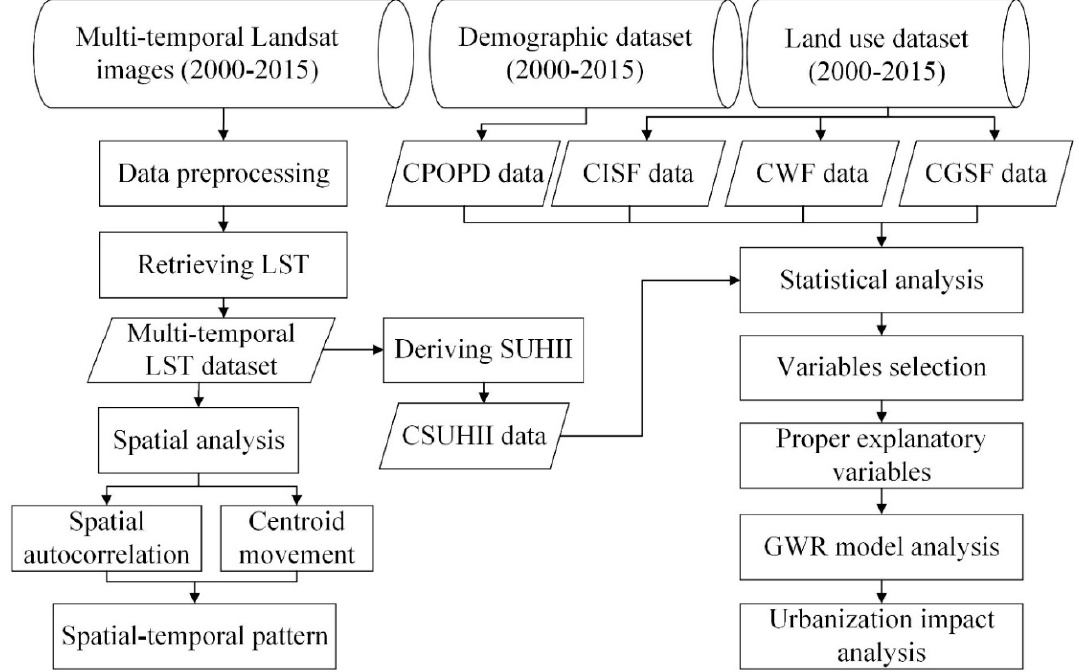
Figure 2. Methodology of our study. CSUHII, changes in SUHI intensity; CPOPD, changes in population density; CISF, changes in impervious surface fraction; CWF, changes in water fraction; and CGSF, changes in green space fraction.